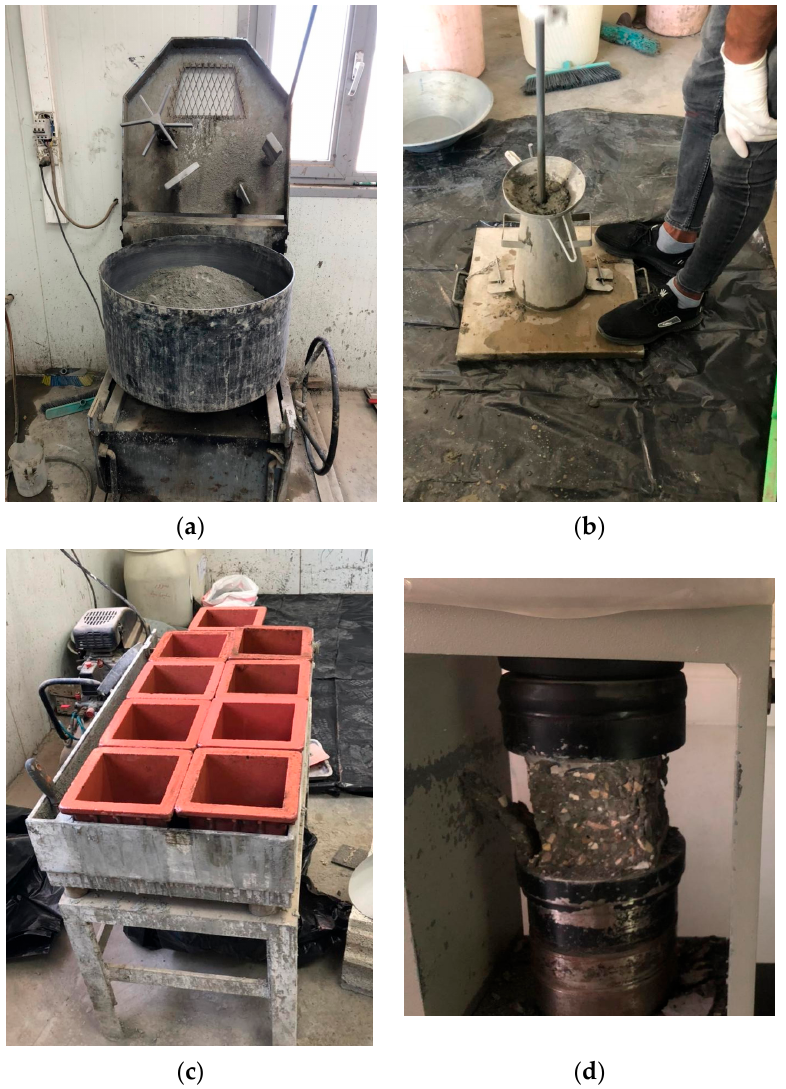
Figure 1. Experimental work ( a ) concrete mixer, ( b ) slump test, ( c ) cubic molds, ( d ) compressive strength